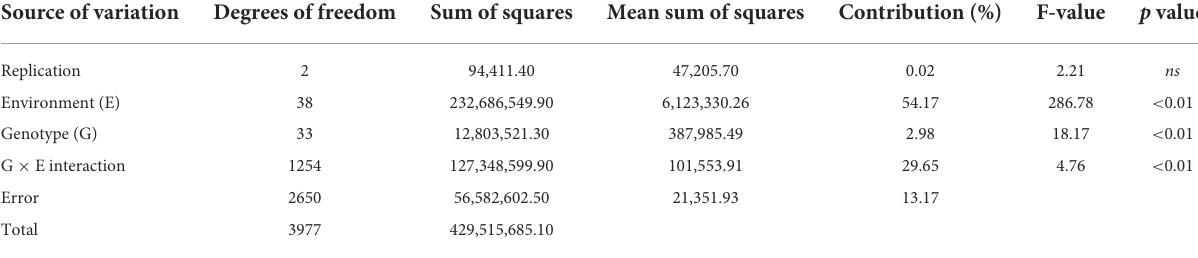
TABLE 2 Analysis of variance for grain yield (kg ha − 1 ) in 34 genotypes of mungbean evaluated over 39 environments in India. Source of variation Degrees of freedom Sum of squares Mean sum of squares Contribution (%) F-value p value